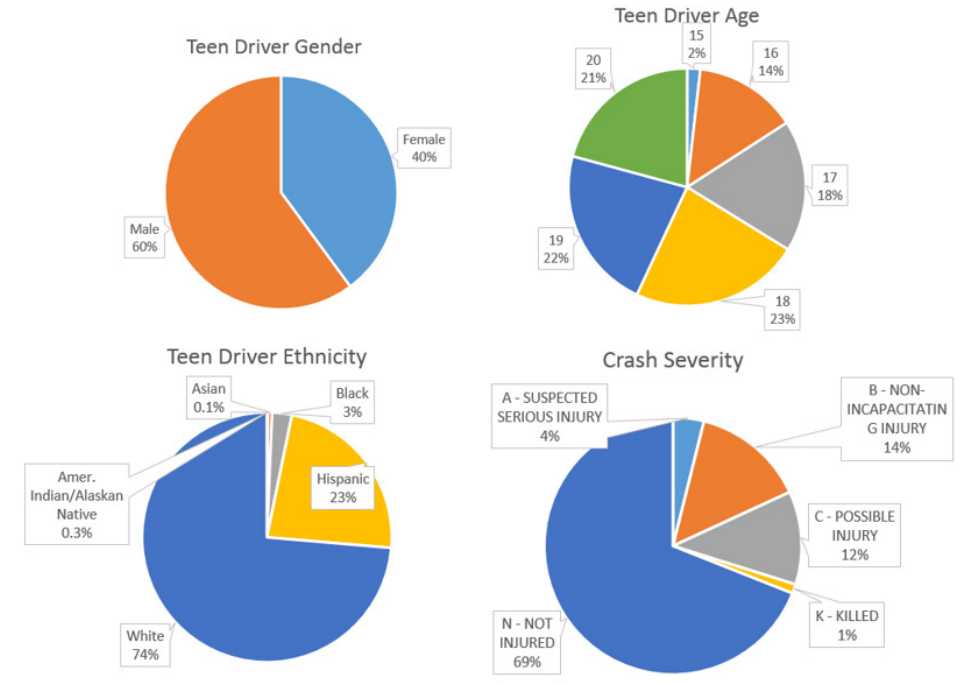
Figure 5. Other exploratory analysis on teen drivers and crash severity.